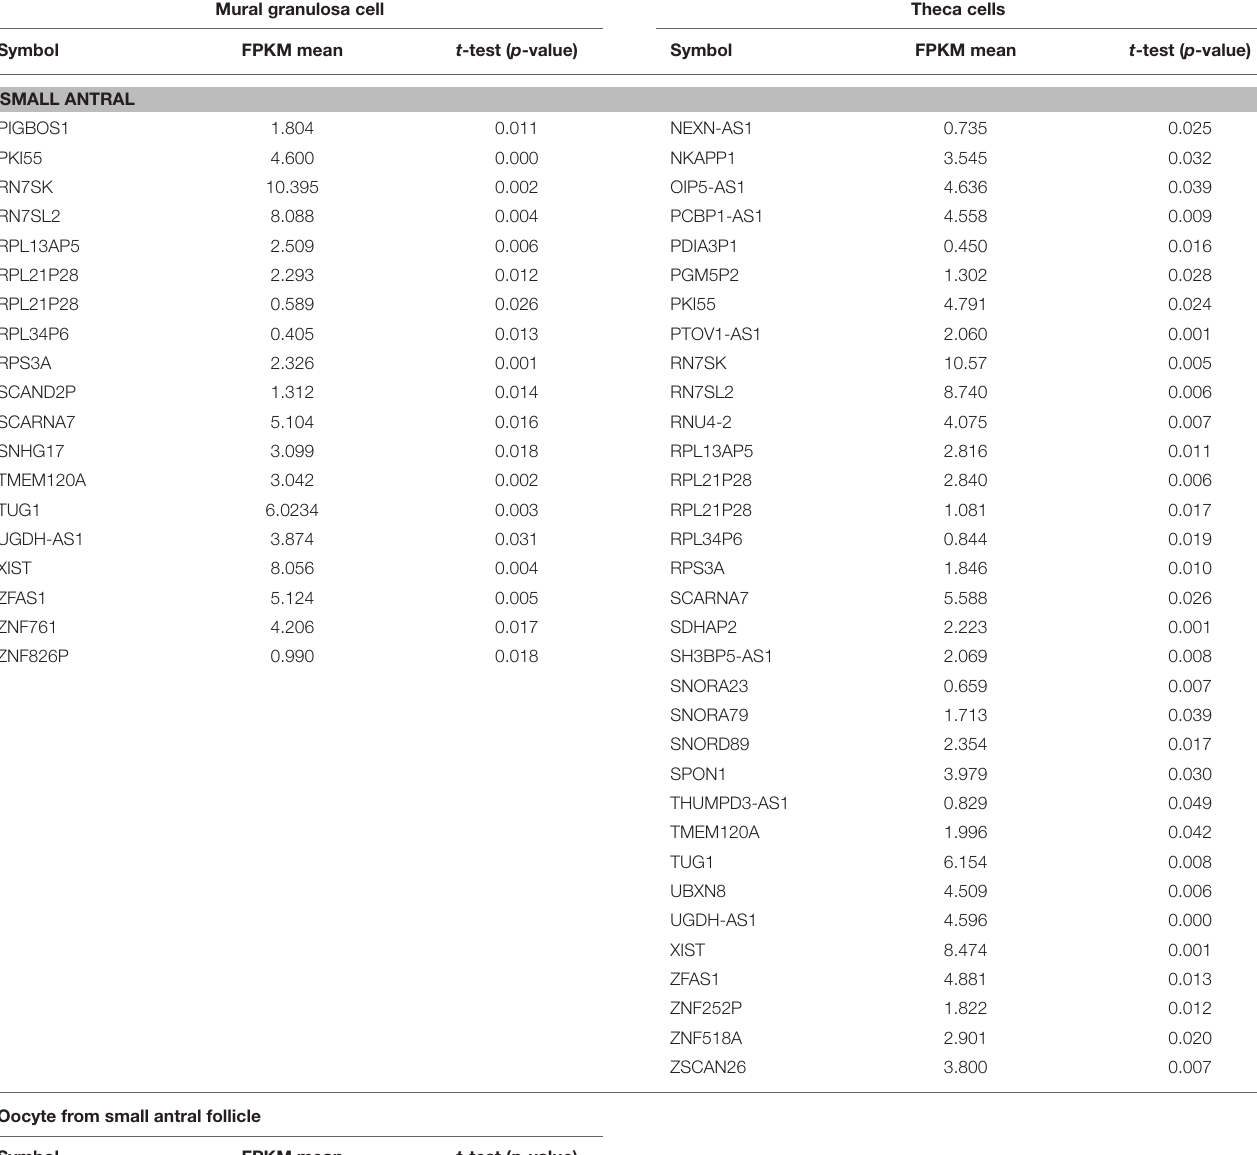
*1 Genes alphabetically sorted. *2 Presented in heat map ( Figure 2 ). from primordial follicles, as well as in primordial follicles ( Table 2). We interrogated the TAF15 protein using a specific antibody toward TAF15. This showed detection of the TAF15 protein in both oocyte and granulosa cells of primordial